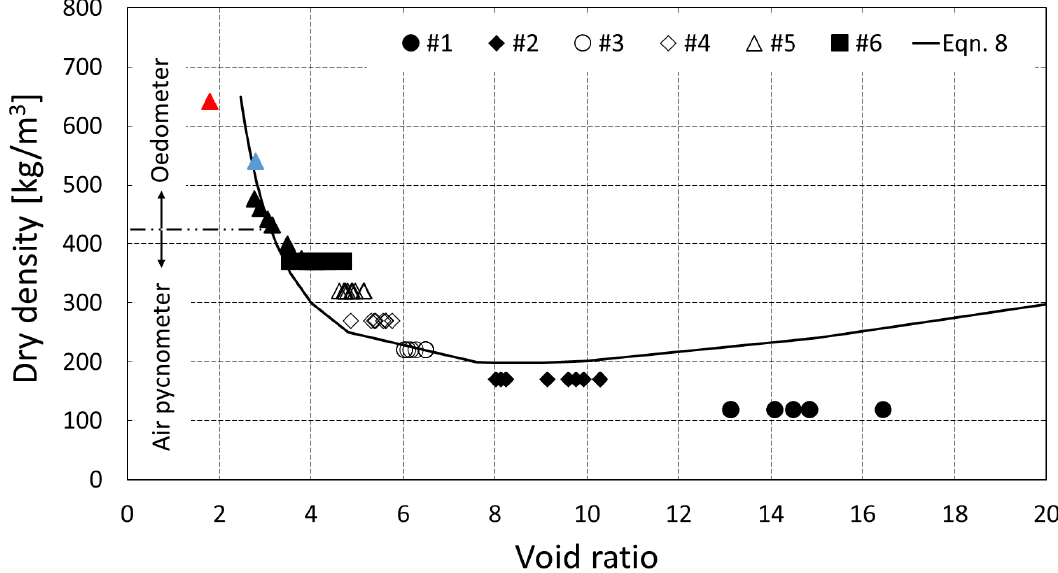
vs. 𝑒 relationship as predicted with Equation (8). Figure 6. ρ d vs. e relationship as predicted with Equation Figure 6. 𝜌 𝑑